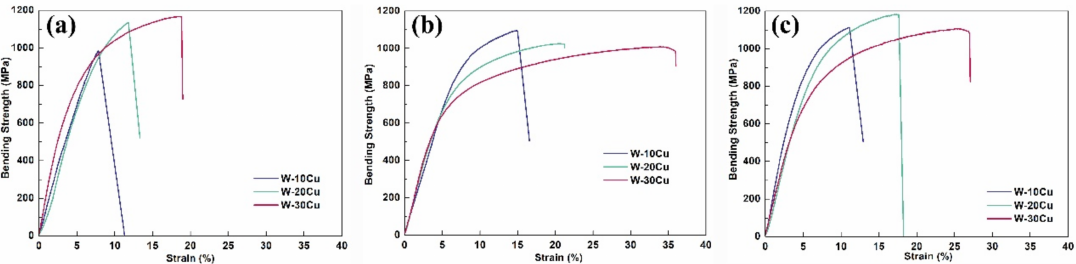
Figure 7. Bending strength-strain curves of the as-prepared W–Cu composites using ( a ) WY–050,